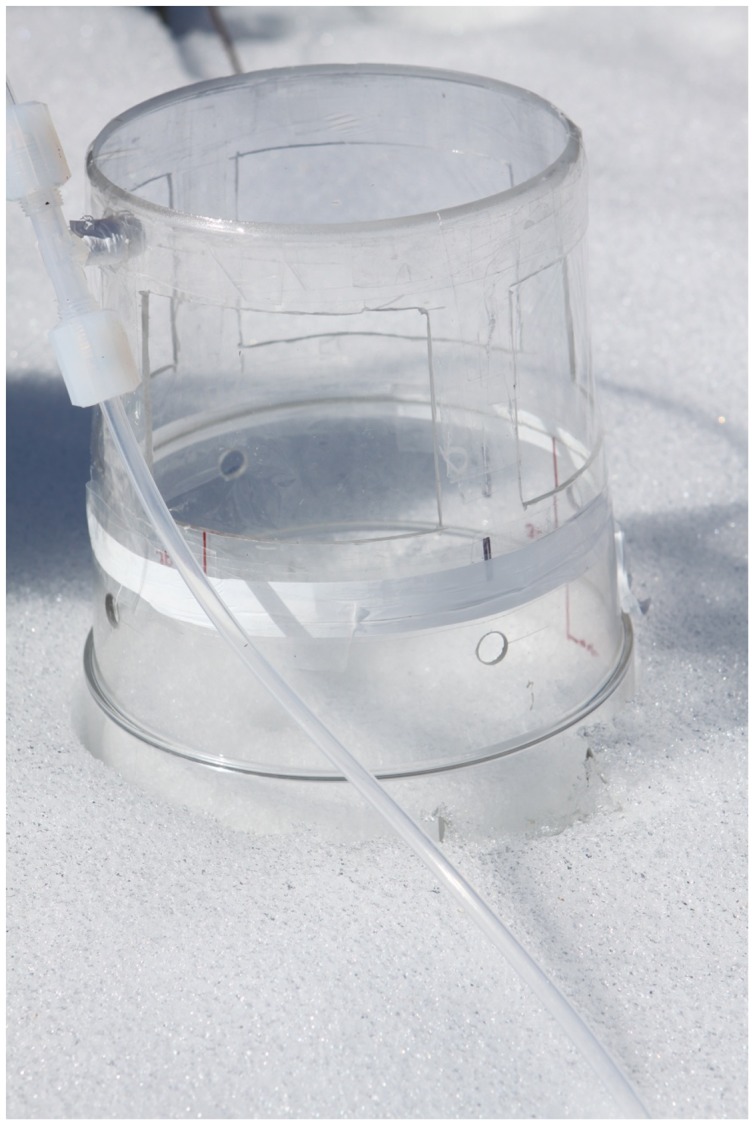
Modified Teflon Fluorinated Ethylene Propylene (FEP) Chamber with Polycarbonate (PC) Frame and 25 µm Teflon FEP Film Top and Side Windows.